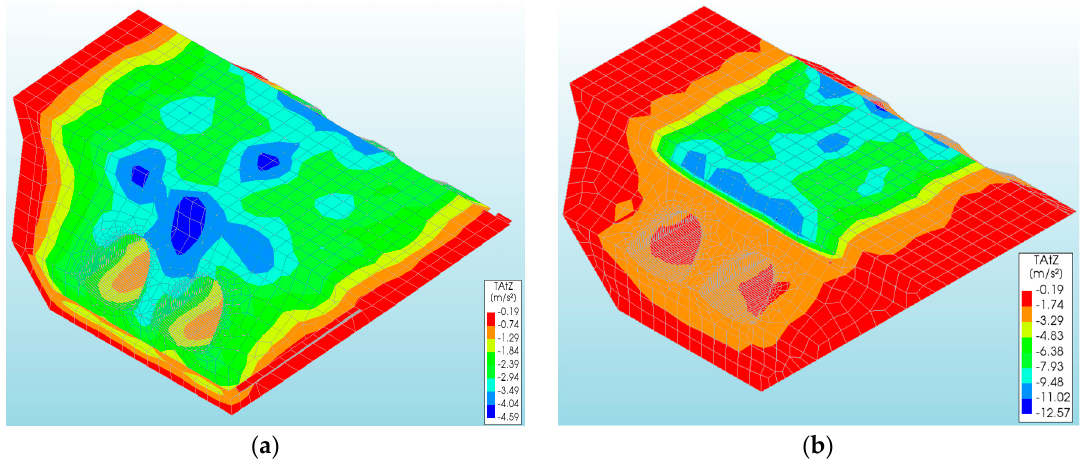
Figure 13. Distribution of backfill acceleration of El Centro for bridge models: ( a ) Ib and ( b ) IIb.